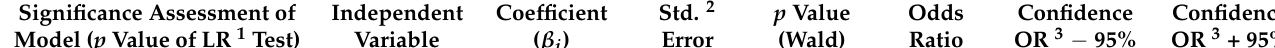
Table 3. Results logistic regression models. Active surveillance model